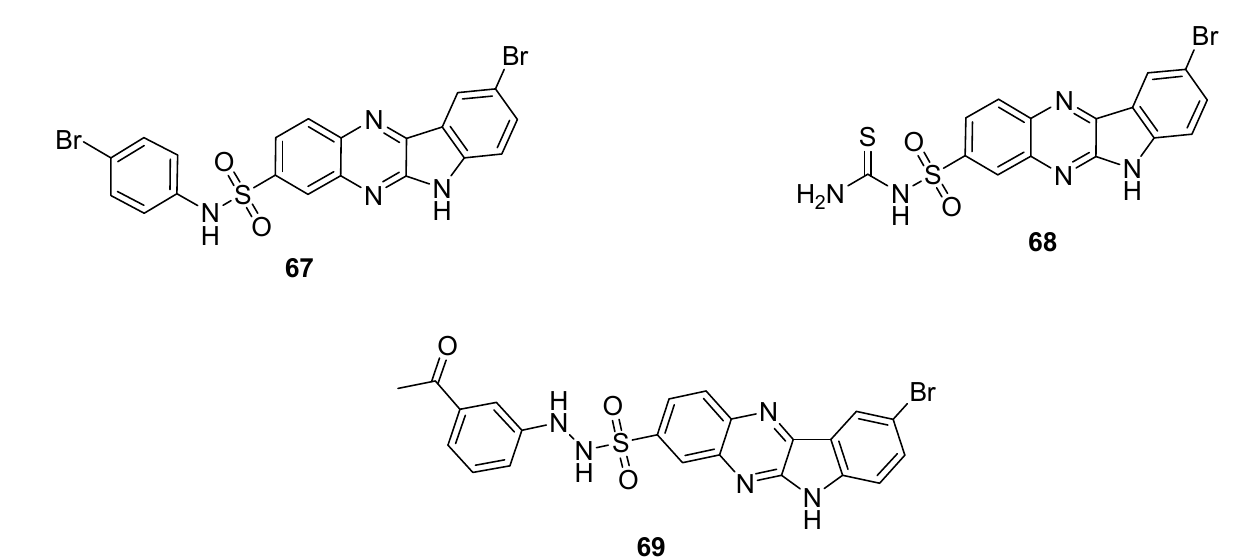
Figure 10. Substituted quinaxoline sulfonamide derivatives 67–69 . Table 4. Antimicrobial activity of quinoxaline-substituted benzene sulfonamide derivatives 67–69 .